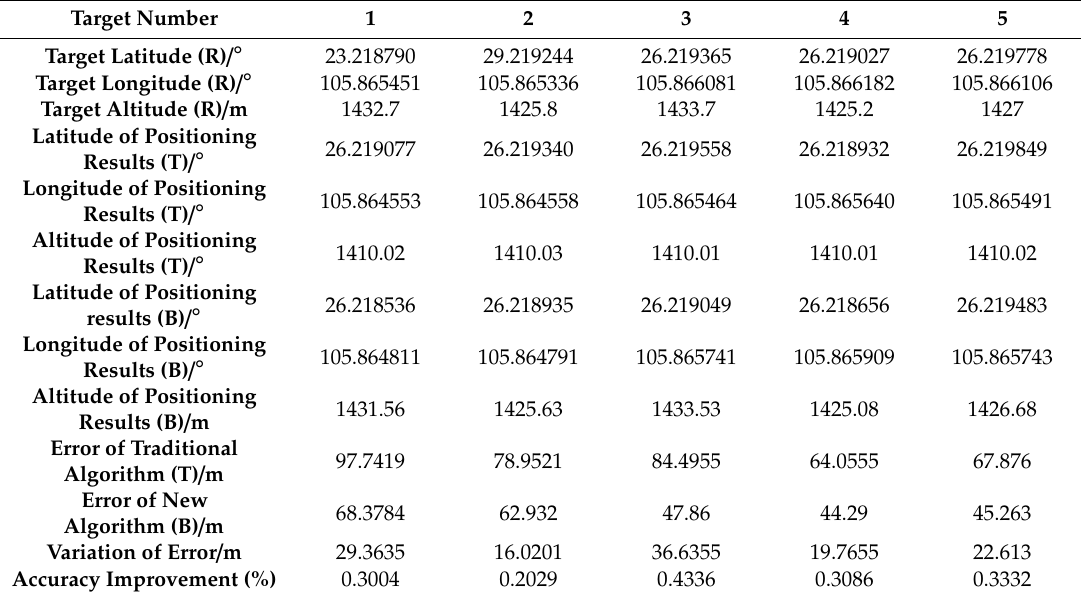
Table 3. Positioning results of Figure